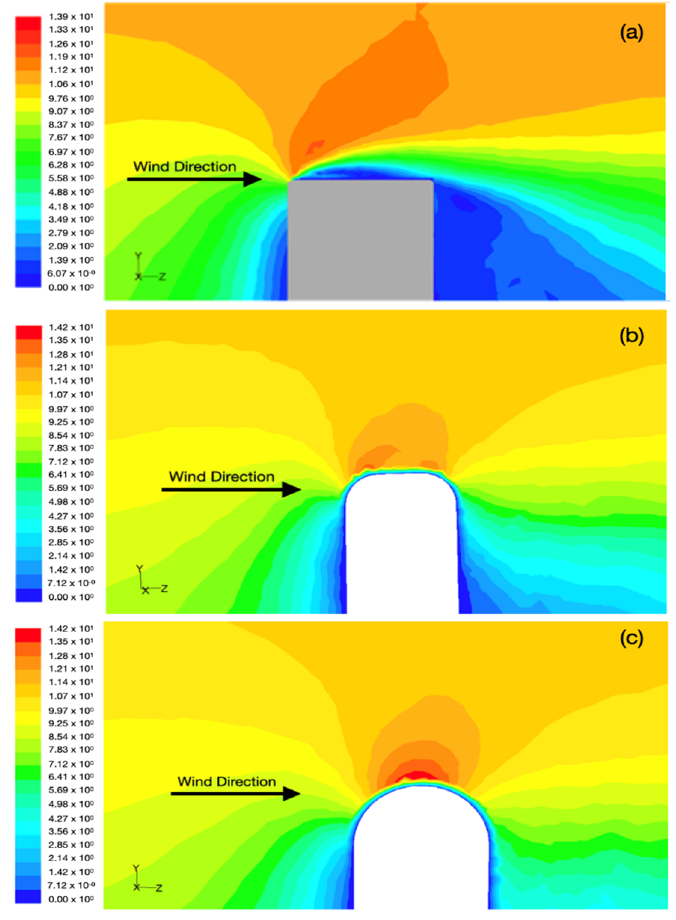
Figure 11. Contour plots of wind velocity magnitude on the side view (X-coordinate) ( a ) building A shows the highest velocity located windward the building; ( b ) building B shows the highest velocity near the rounded shape in front and back the building; ( c ) building C shows the wind velocity is more stable, centered in the middle.